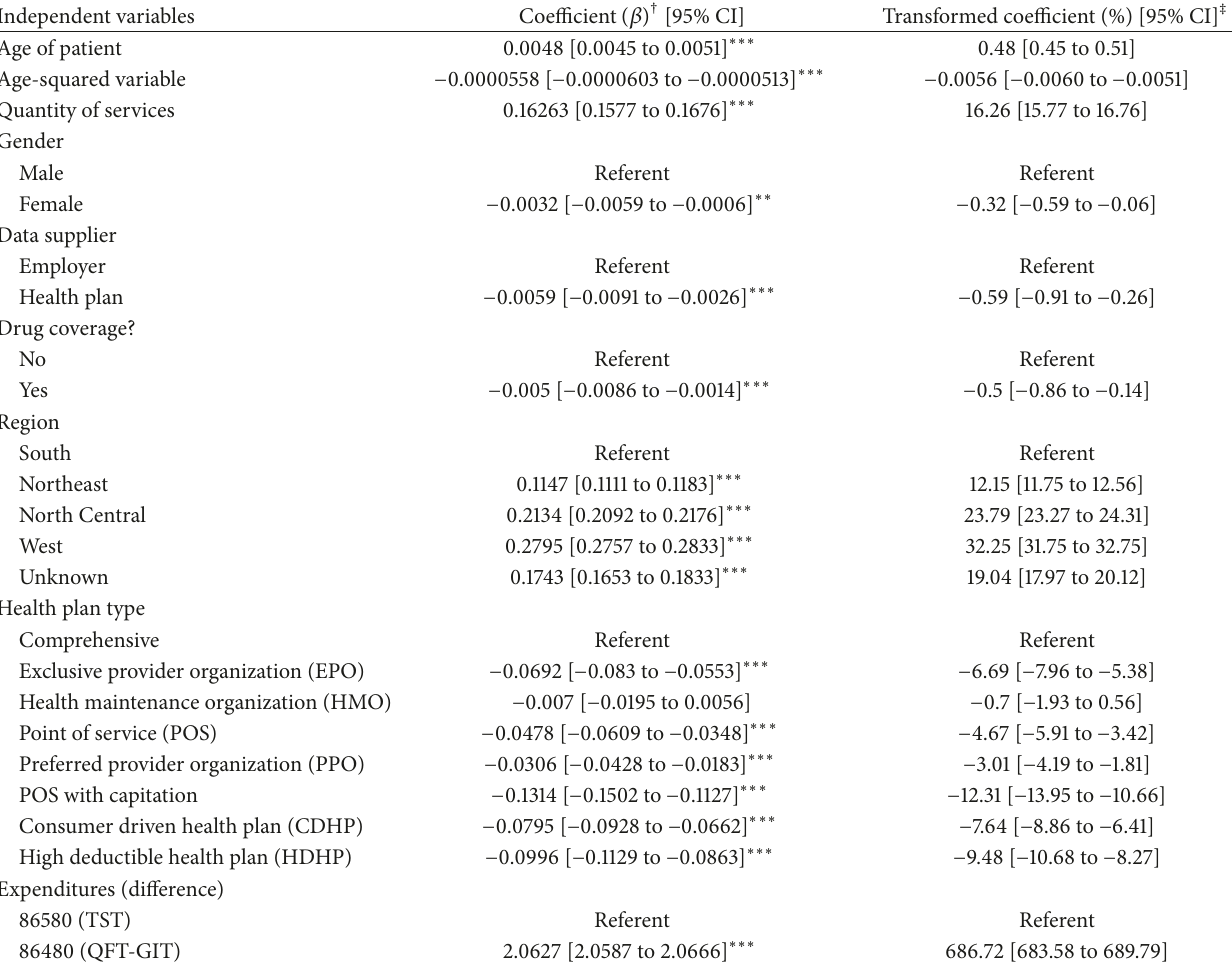
Table 2: Summary regression results. Dependent variable: log of the medical expenditures of test for 86580 (TST) and 86480 (QFT-GIT). 𝑁 = 628, 595